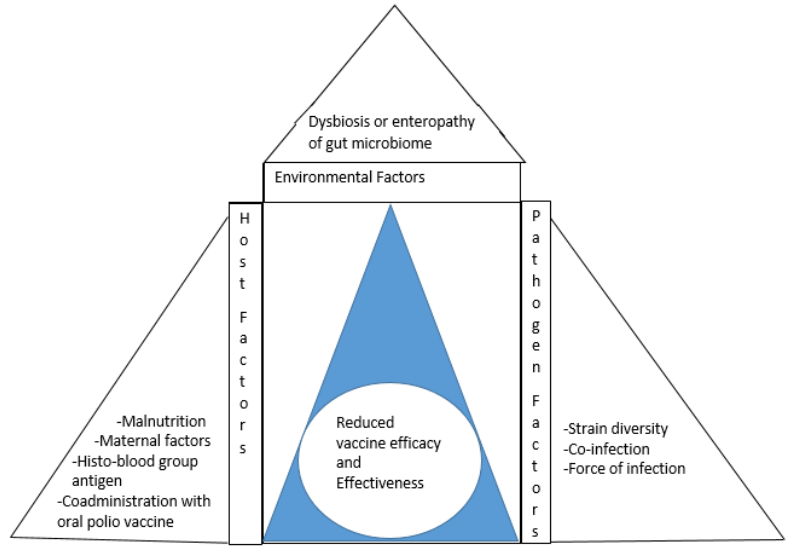
Figure 3. Epidemiological triad of factors impacting oral rotavirus vaccine performance.